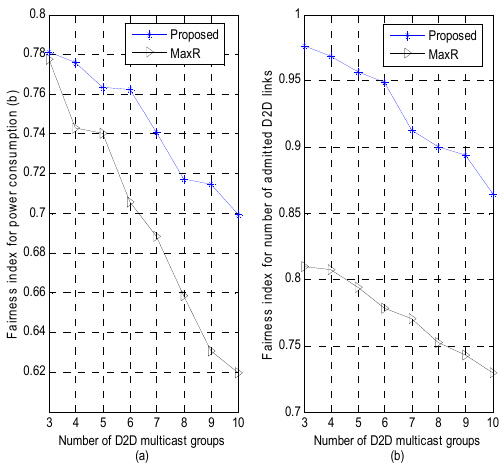
Figure 7. Fairness index versus number of D2D multicast groups: ( a ) Impact of the number of D2D